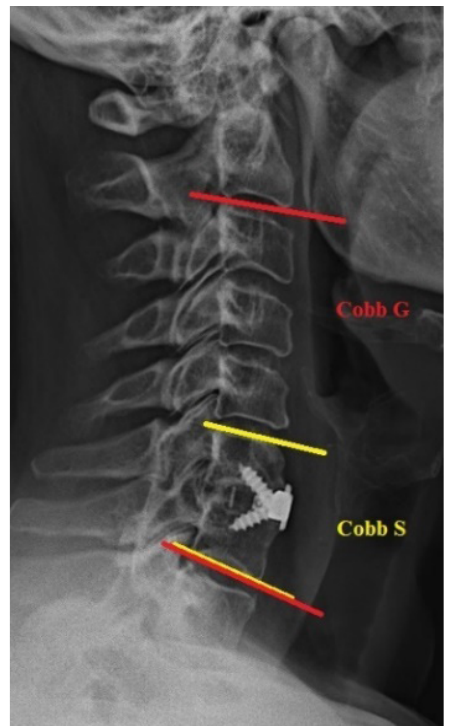
Fig. 1. Lateral X-ray after ACDF with Zero-P VA ® cage in levels C5-6, C6-7 (authors’ archive).